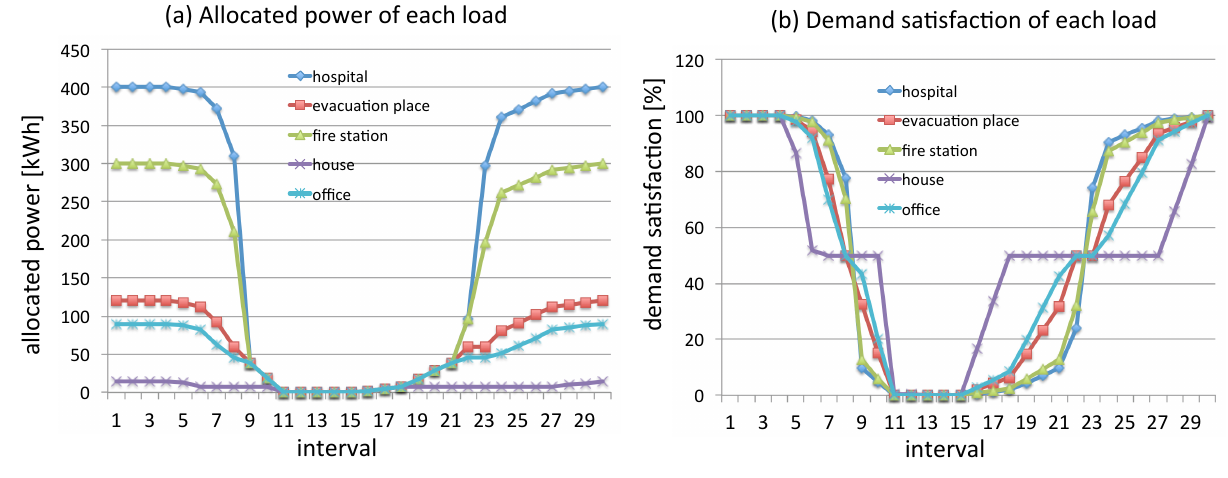
Figure 15. Allocated power and demand satisfaction in a no-priority